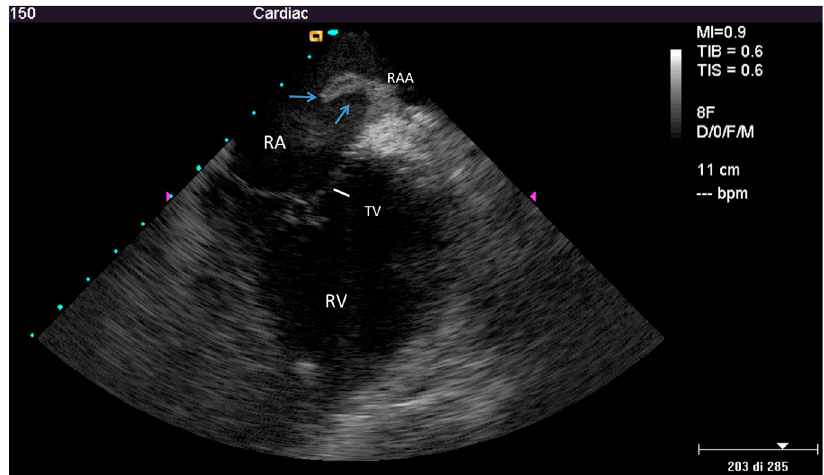
Figure 5. Ghost after lead extraction by ICE. Modified home view by ante-flexion, to gain a close-up of the right ventricle. Mobile hypo-echogenic mass (arrows) in the right atrium attached at the origin of right atrial appendage. In the movie, other smaller floating masses are also seen, attached to the superior vena cava. RAA—right atrial appendage; other abbreviations as in Figure 3.